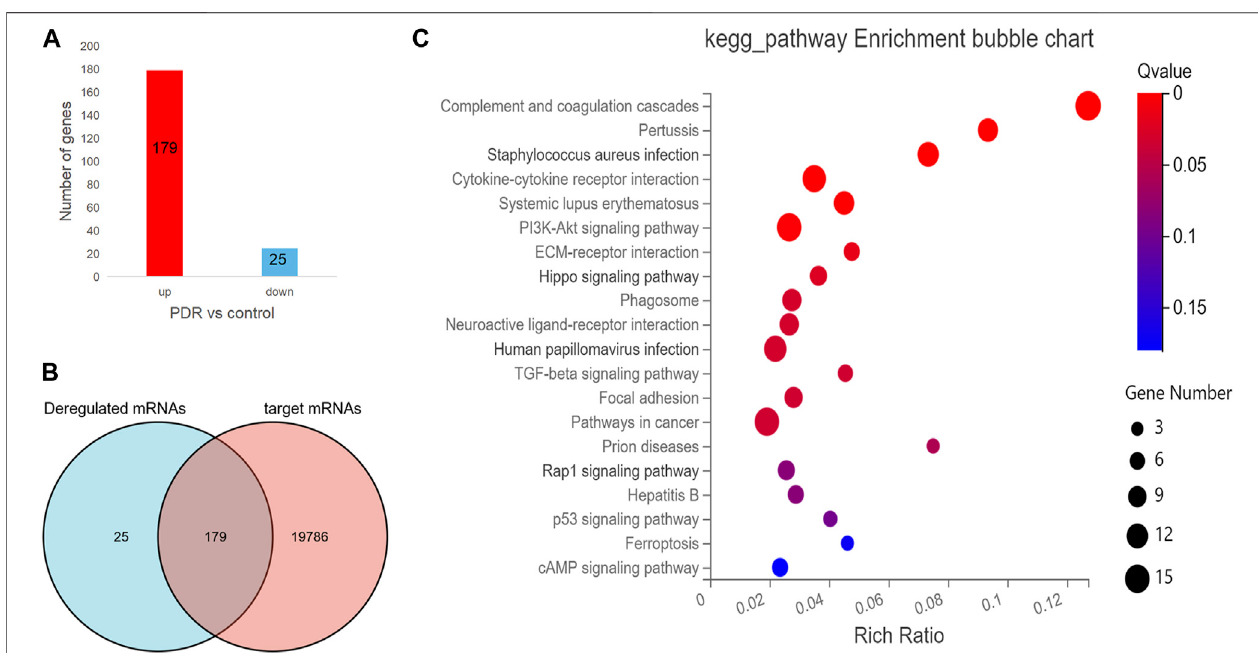
FIGURE 5 | The analysis for the protein-coding mRNA pro fi le in GSE160310 data. (A) Bar graph in red visualizes 179 upregulated protein-coding mRNAs in PDR patients compared with controls; bar graph in yellow represents 25 downregulated protein-coding mRNAs in PDR patients compared with controls. (B) Venn diagram describes the 179 overlapped mRNAs between the 19,984 target mRNAs in our experiment and 204 deregulated protein coding mRNAs in the GSE160310 pro fi ling data. (C) Bubble diagram exhibits the top 20 KEGG pathway analyses of 179 overlapped